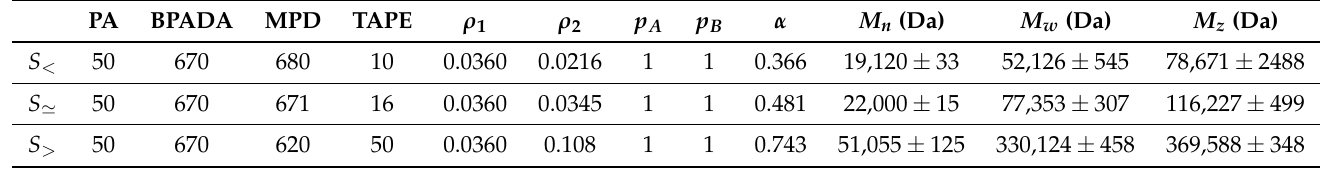
Table 2. Three fully reacted, stoichiometric systems below, around, and beyond the gel point. The first column is the system label. The next four columns list the number of each type of monomers. The values of ρ 1 and ρ 2 are determined from the monomer numbers. The value of α is computed using Equation (20). The average molecular weights, M n , M w , and M z , are from the MC